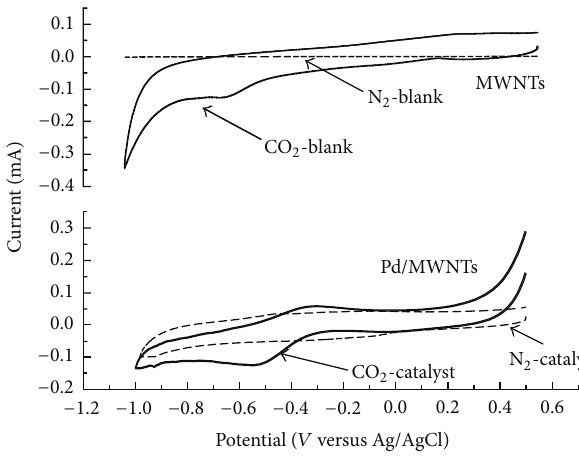
Figure 5: Cyclic voltammograms for MWNTs and Pd-MWNTs by catalyst modified glassy carbon electrode in 0.5mol/L KHCO 3 solution.